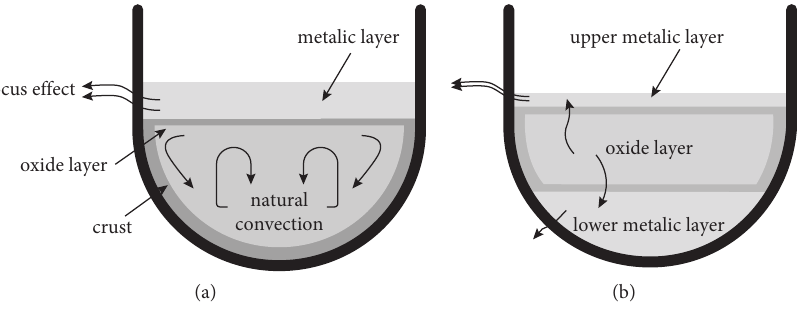
Figure 2: Molten pool configurations: (a) two layers and (b) three layers.